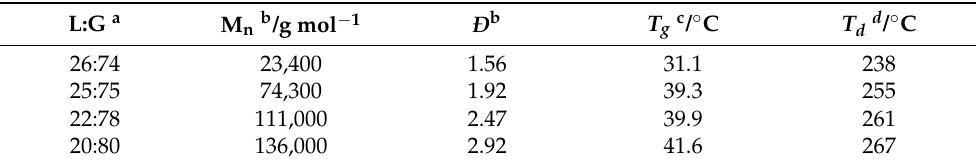
Table 3. Thermal properties of PLGA25 of varying molecular weights. T g = glass transition tempera- ture. T d = temperature of 5%